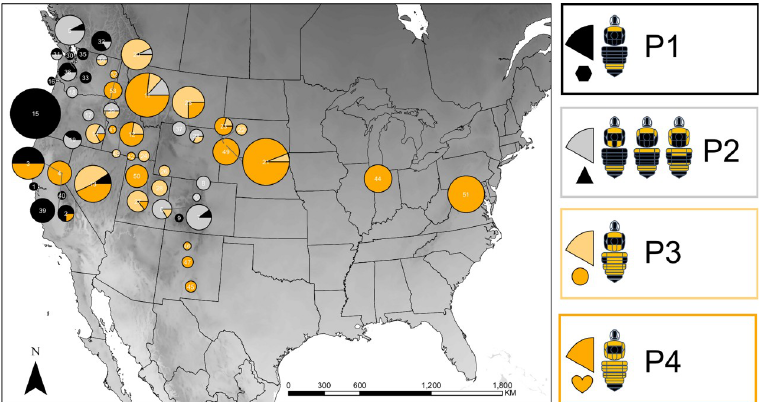
Fig 1. Distribution of the major phenotypes associated with B . fervidus and the nominal B . californicus in the United States. The size of each circle represents the number of specimens associated with each locality. The color of each pie slice represents the proportion of specimens exhibiting one of four phenotype (P) classes. Shapes ( i . e ., hexagon, triangle, circle, and heart) below each pie slice correspond to the phenotype diagrams presented in Fig 2. Phenotype diagrams are modified from Williams et al. [15]. The number at the center of each pie chart represents the field sites described in Table 1. P1-P3 = B . californicus , P4 = B . fervidus .